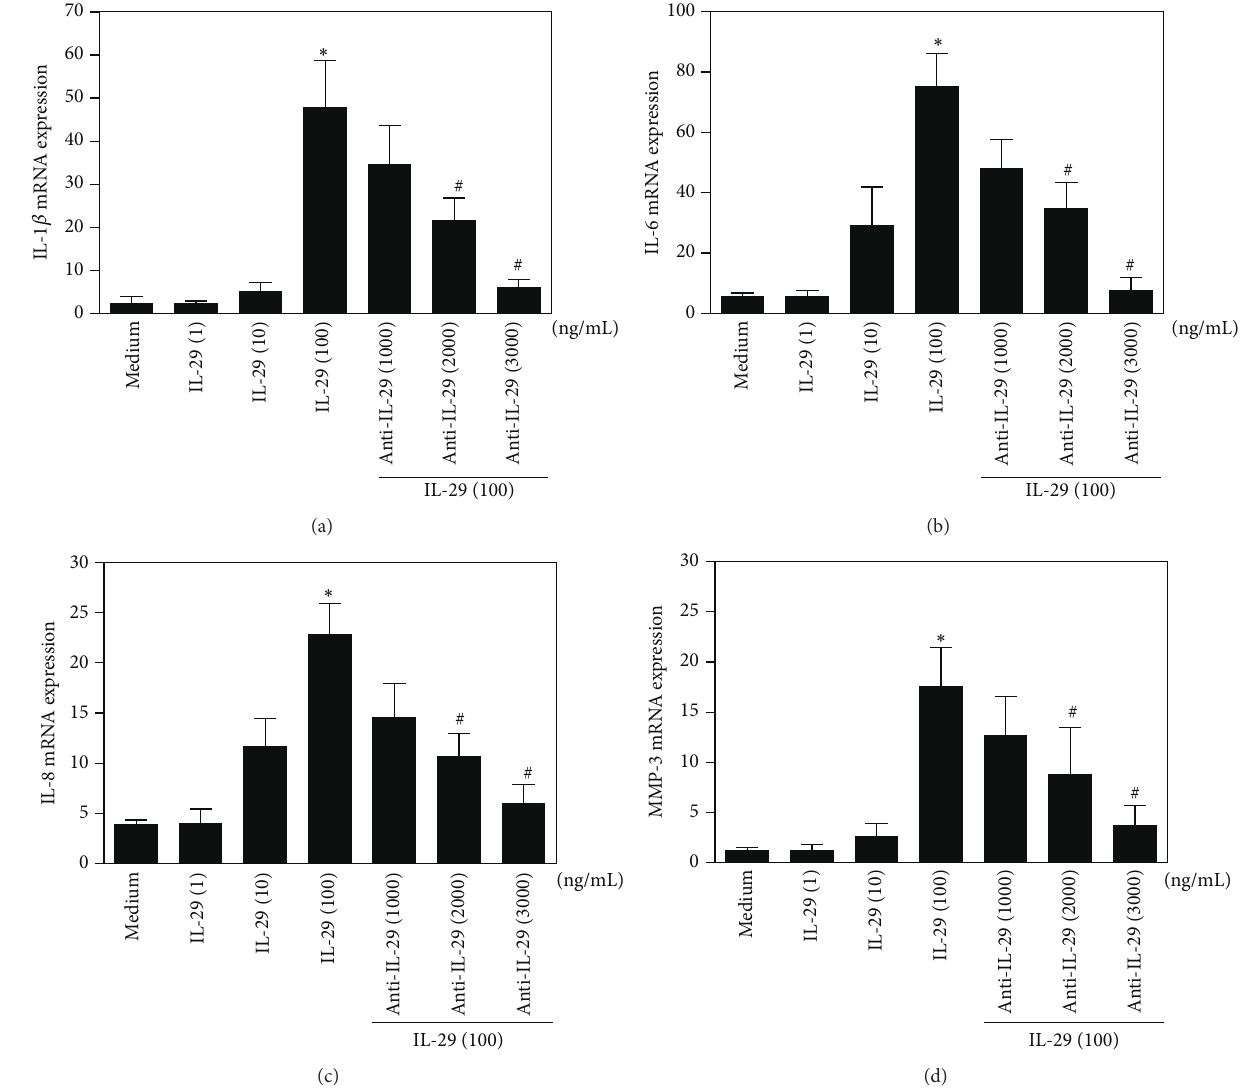
Figure 4: IL-29-induced cytokine expression by OA synovial fibroblasts. mRNA levels of IL-1 𝛽 (a), IL-6 (b), IL-8 (c), and MMP-3 (d) in OA FLS after exposure to IL-29 (1, 10, and 100 ng/mL) with or without its blocking antibody for 48h were determined by real-time PCR. The results shown are representative of one of three independent experiments. The error bars represent mean ± SEM for triplicate wells. ∗ 𝑃 < 0.05 versus medium control. # 𝑃 < 0.05 versus IL-29 (100ng/mL) treatment